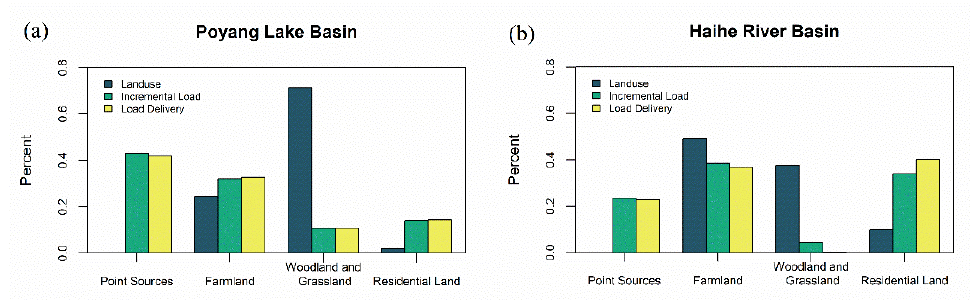
Figure 11. Comparison of land use, incremental load, and load delivery among ( a ) PLB and ( b ) HRB.